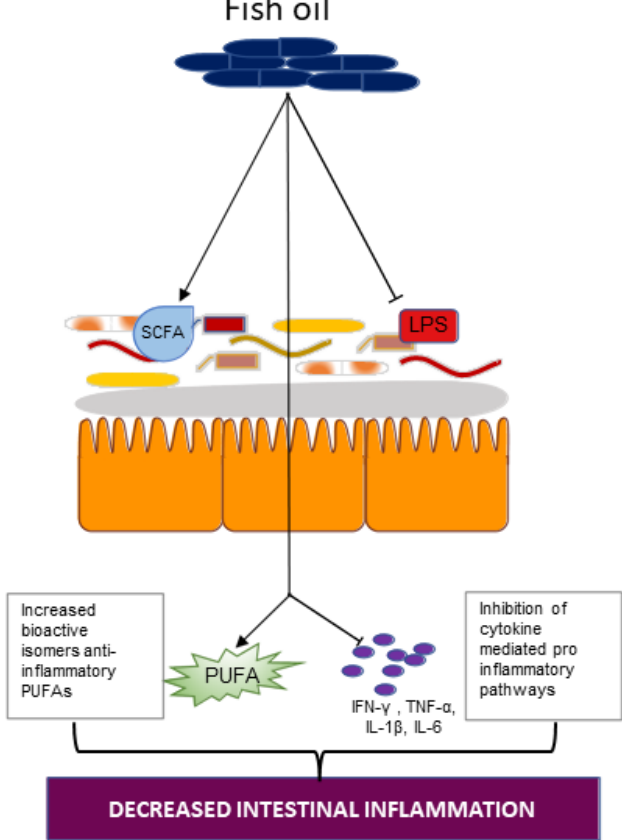
Figure 4. Action of fish oil supplementation on the intestinal ecosystem. Fish oil supplementa- tion increases SCFA-producing microbes while decreasing LPS-producing gut bacteria. Fish oil supplementation may also encourage production of bioactive isomers of the anti-inflammatory polyunsaturated fatty acid (PUFA)-conjugated linoleic acid by the Bifidobacterium while inhibiting cytokine-mediated, proinflammatory pathways. These all lead to a reduction in intestinal inflamma- tion. (SCFA, short chain fatty acid; LPS, lipopolysaccharide; PUFA, polyunsaturated fatty acid; IFN, interferon; TNF, tumor necrosis factor; IL, interleukin).